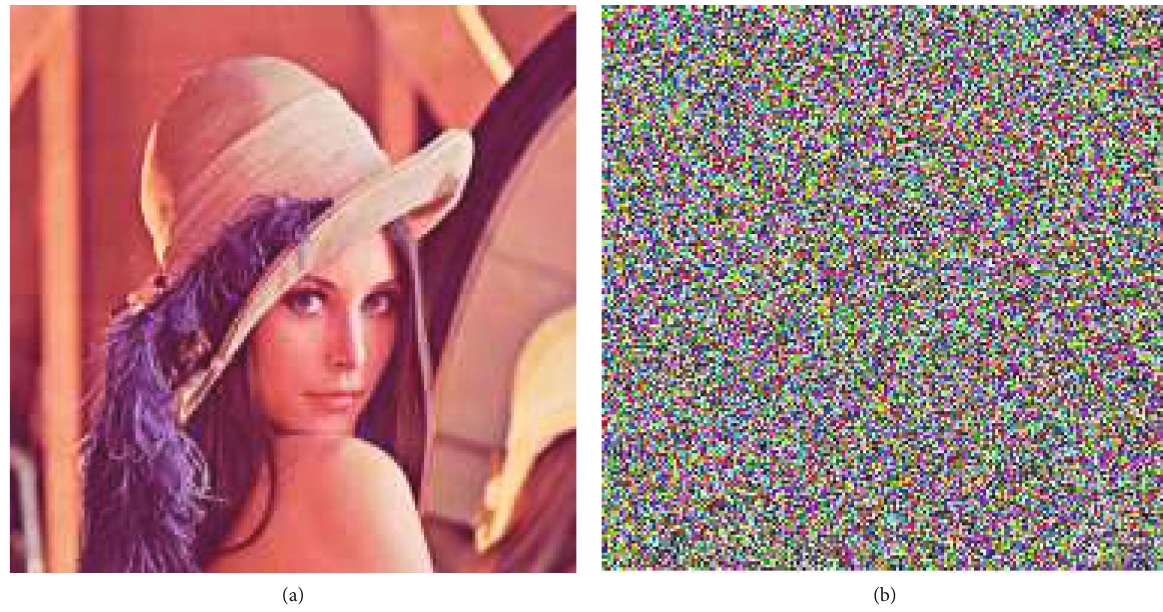
Figure 5: Key sensitivity analysis. (a) Restored of the correct key. (b) Restored of the wrong